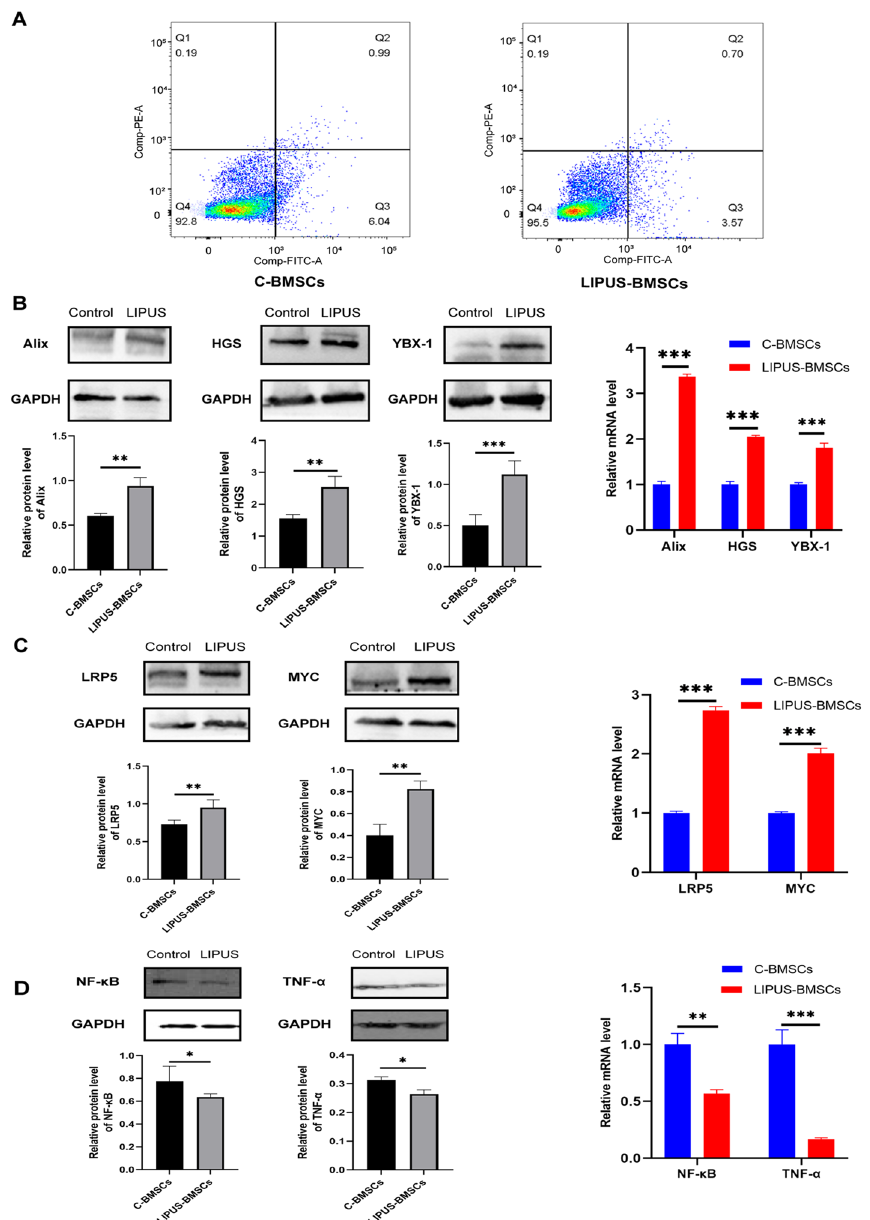
Fig. 2 LIPUS promoted the proliferation, EVs secretion and anti-inflammatory effects of BMSCs. A Flow cytometry analysis of cell apoptosis for C-BMSCs and LIPUS-BMSCs. B Protein and mRNA expression of Alix, HGS and YBX-1 measured by western blotting and qPCR. C Protein and mRNA expression of LRP5 and MYC measured by western blotting and qPCR. D Protein and mRNA level of IL-8, NF-κB and TNF-α detected by western blot and qPCR, respectively. Error bars represent mean SD ( n 3 per group). ns p > 0.05, * p < 0.05, ± = ** p < 0.01, *** p < 0.001. Statistical significance assessed by unpaired two-tailed t -test. EVs, extracellular